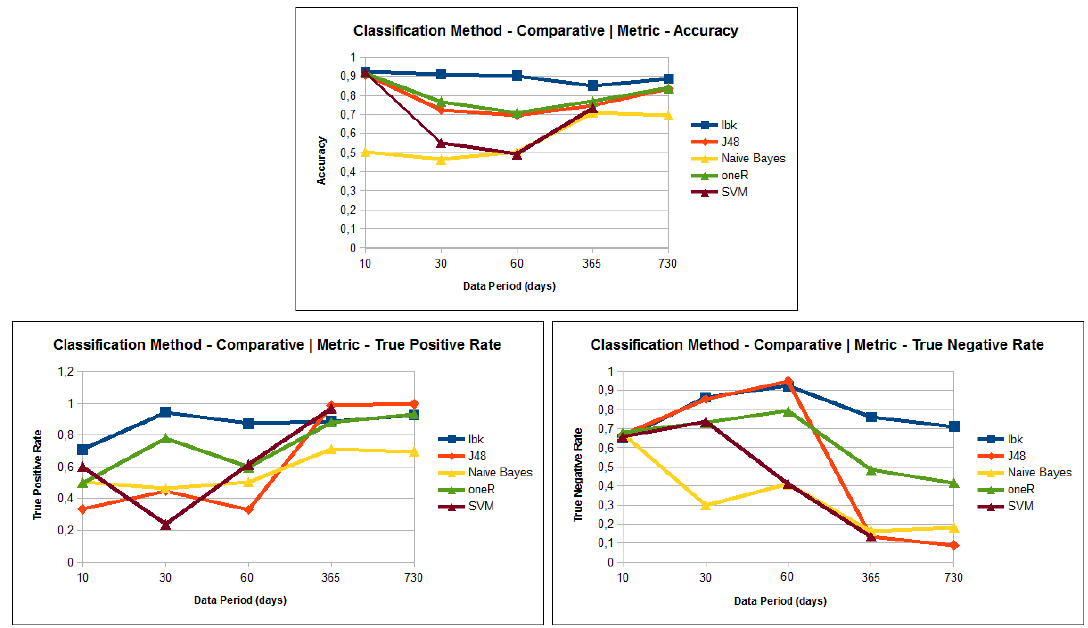
Figure 4. Results of the first set of